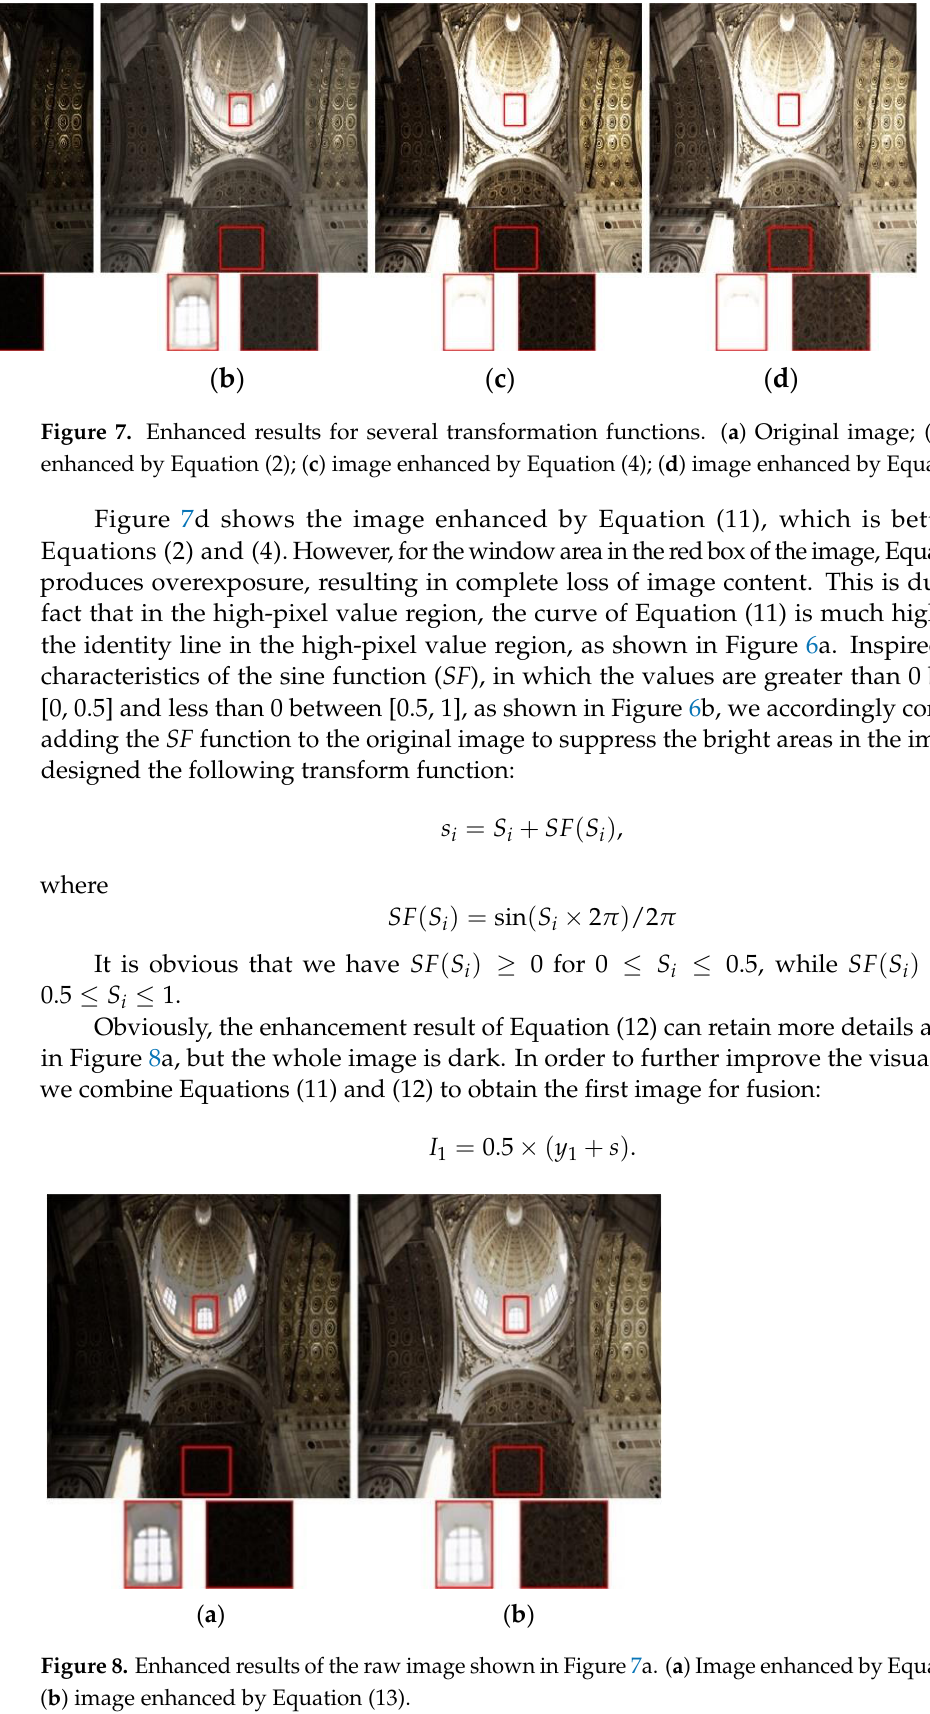
( b ) Figure 6. Different transformation function graphs. ( a ) The graphs of Equations (2), (4), (11) and (13); ( b ) Graph of the SF function. Figure 7 displays one raw low-light image and its counterparts enhanced by different transform functions. Both GC (2) and truncated normalized sigmoid (4) can enhance the brightness of the image. However, Equation (4) has limited enhancement ability for dark regions marked by red boxes, as shown in Figure 7c. Observing the curves of each formula